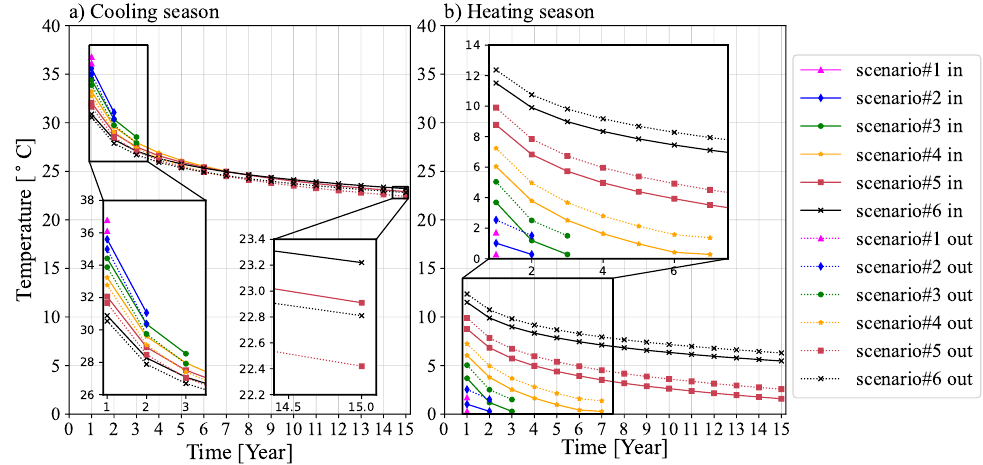
Figure 8. Evolution of inflow and outflow temperature of BHE #5 in the end of ( a ) cooling season and ( b ) heating season over 15